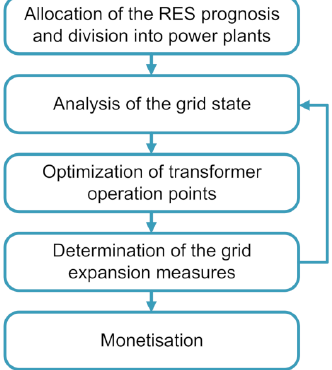
Figure 2. Classical planning method for medium-voltage